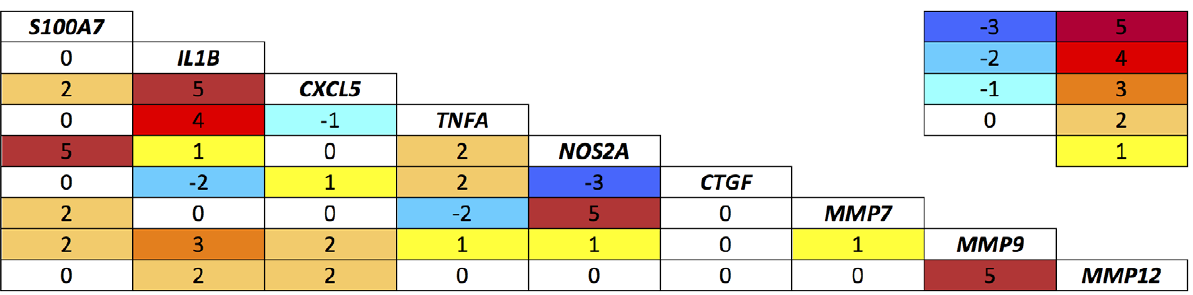
Figure 1. Partial correlation matrix of gene expression. Number of occasions (maximum 5) on which the partial correlation coefficient of expression of each target relative to the other were positively or negatively correlated at the p , 0.05